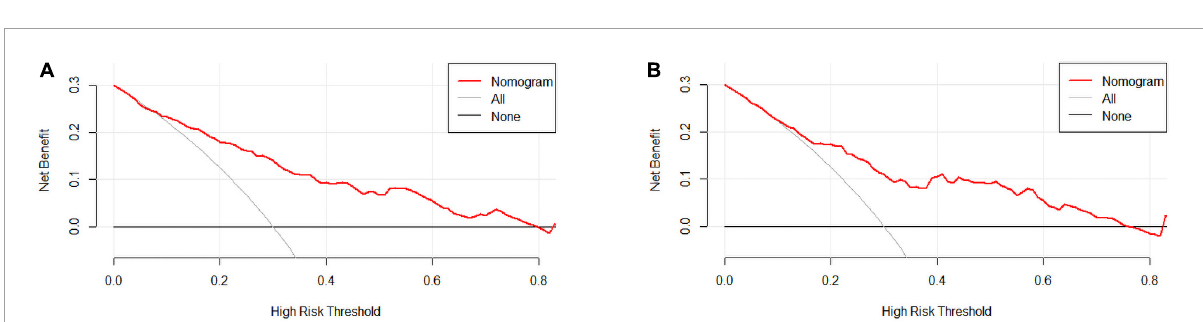
FIGURE5 (A) Training set and (B) Validation set. Decision curve analysis (DCA) for the coronary heart disease (CHD) prediction nomogram. The y-axis measures net benefit. DCA shows the clinical usefulness of the nomogram score, according to a continuum of potential thresholds for CHD risk (x-axis) and the net benefit of using the nomogram to stratify patients according to risk (y-axis). Weighting factor = threshold probability/(1-threshold probability). Net benefit = true positive rate–(false positive rate × weighting factor). The red line represents the incidence risk nomogram of CHD. The gray line represents the assumption that all patients are diagnosed with CHD. The thin thick solid line represents the assumption that no patients are diagnosed with CHD.